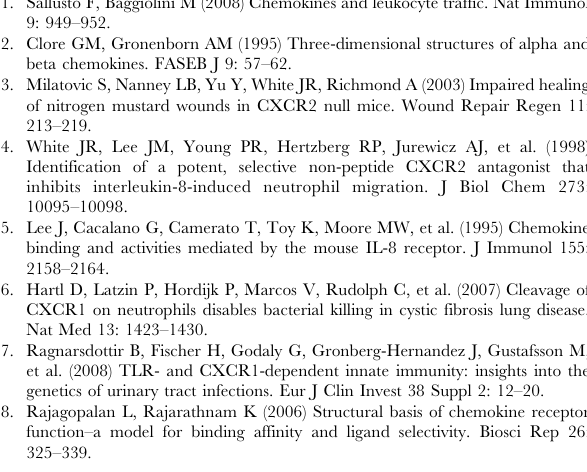
Figure S2 The mutant R6H-CXCL8 did not displace the 125 I-CXCL1 or 125 I-CXCL8 bound to HL-60 cells express- ing CXCR2. HL-60 cells expressing CXCR2 were incubated with 125 I-CXCL1 (1 nM, A ) or 125 I-CXCL8 (0.16 nM, B ) in the absence or presence of increasing concentrations of unlabeled CXCL1 or CXCL8 or R6H-CXCL8 or CC-CXCL8 at 4 u C for 5 h. The 100% specific binding corresponded to the binding of 125 I-CXCL1 in the absence of unlabeled chemokine minus the binding of 125 I-CXCL1 in the presence of 200 nM of unlabeled CXCL1 ( A ). Similarly, the 100% specific binding corresponded to the binding of 125 I-CXCL8 in the absence of unlabeled chemokine minus the binding of 125 I-CXCL8 in the presence of 200 nM of unlabeled CXCL8 ( B ). Values are means of triplicate determina- tions, and the bars of each point represent the standard errors. Figure S3 Dose-dependent calcium responses in HL-60 cells expressing CXCR1. HL-60 cells expressing CXCR1 loaded with Indo-1 were stimulated with different concentrations of wild-type CXCL8 or CC-CXCL8. The intracellular calcium response stimulated by 100 nM CXCL8 is referred as 100%. The EC 50s for CC-CXCL8 and CXCL8 were 316 nM and 4 nM, respectively. Values are means of triplicate determinations, and the bars of each point represent the standard errors. Figure S4 R6H-CXCL8 and CC-CXCL8 mutants in- duced skin inflammation in rabbits. Prostaglandin E2 (PGE2, 30 nmol per 100 ul) was injected alone (control) or co- injected with 100 nmol of CXCL8, R6H-CXCL8 or CC-CXCL8 into the shaved dorsal skin of rabbits. After 3 h the animals were sacrificed and skin sections were stained with hematoxylin and eosin to identify neutrophil infiltration. Figure S5 R6H-CXCL8 and CC-CXCL8 mutants did not bind Duffy antigen (DARC). Ghost membranes were incubated with 125 I-CXCL1 (1 nM) in the absence or presence